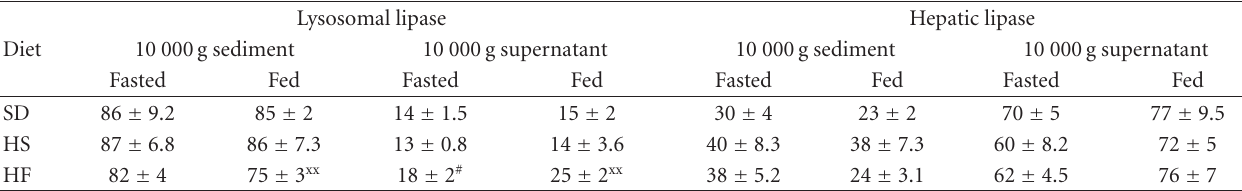
Table 4: The intracellular distribution of lipases activities in liver.